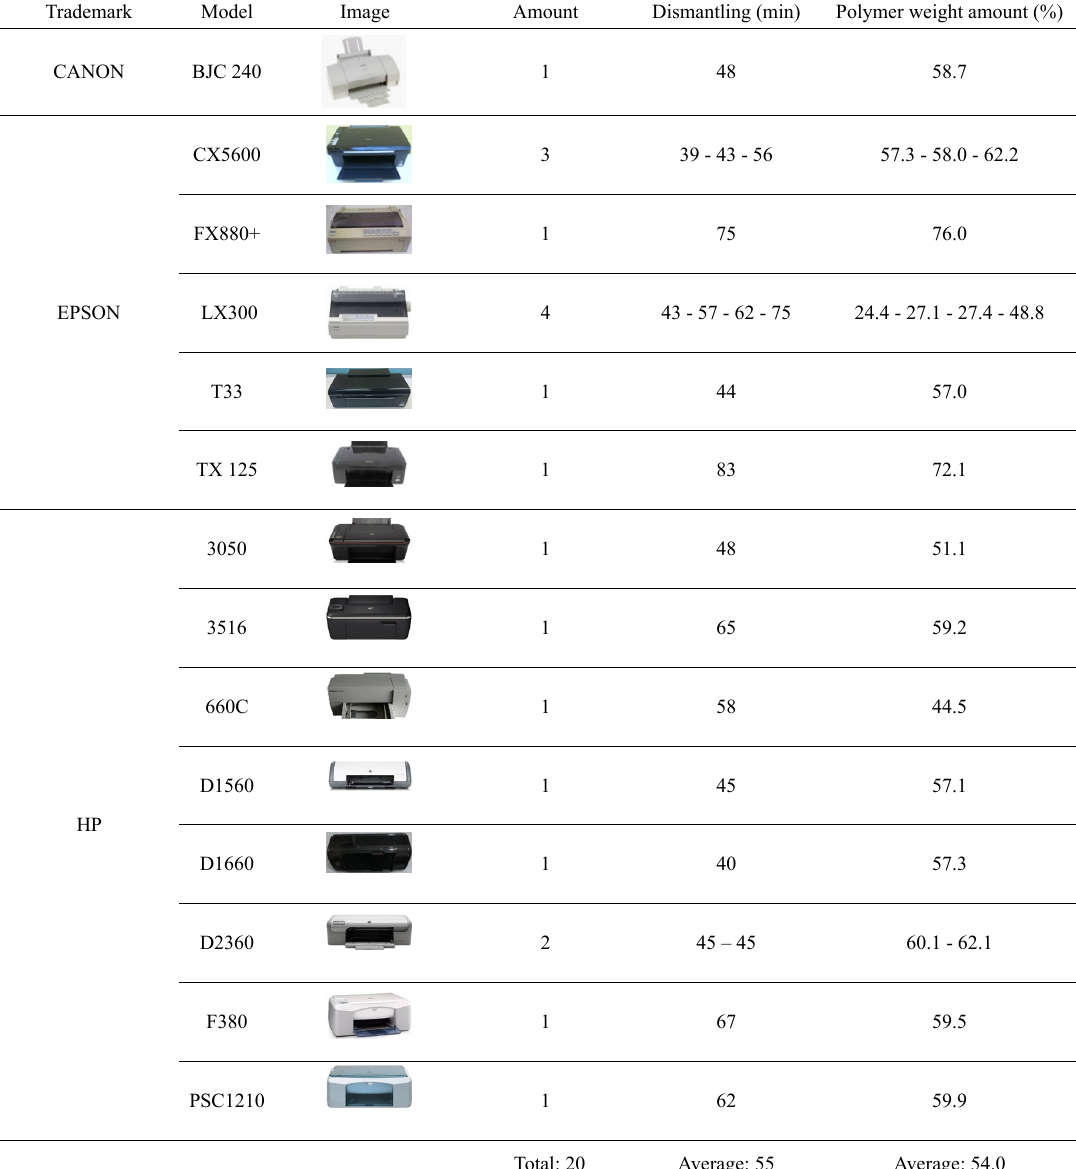
Table 1. Information about the printers.